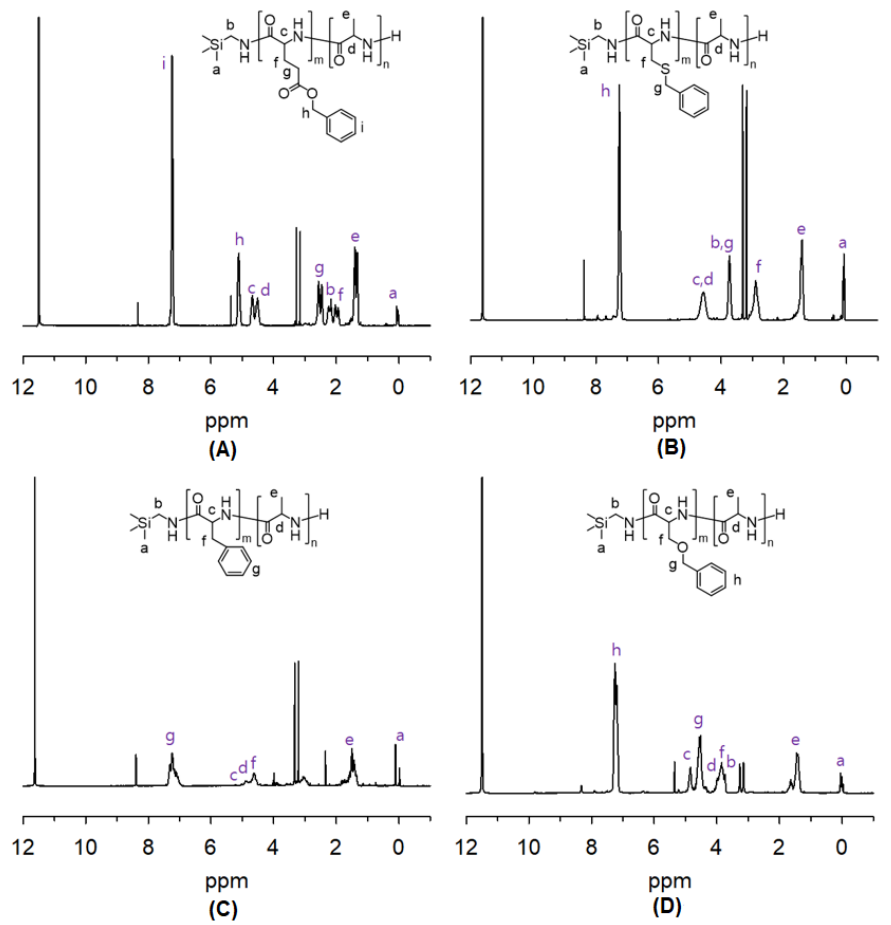
Figure 1. 1 H NMR spectra of ( A ) poly(Ala- co -Bn-Glu), ( B ) poly(Ala- co -Bn-Cys), ( C ) poly(Ala- co -Phe), and ( D ) poly(Ala- co -Bn-Ser) measured in TFA- d .